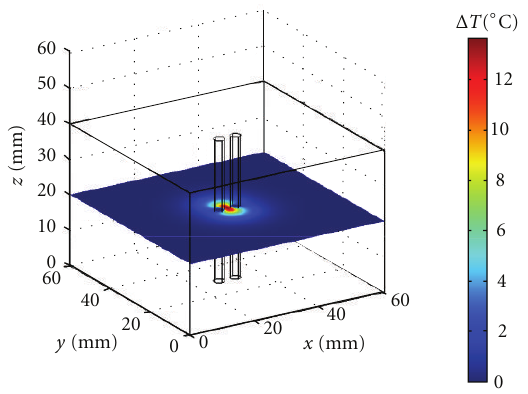
Figure 6: Temperature increase reached at the end of a 60 s in- sonation period at the focal plane for an artery-vein vessel pair and nearby tissue. The vessel and ultrasound parameters are the same as in Figure 1 and the ultrasound focus is at the center of the computational domain between the two